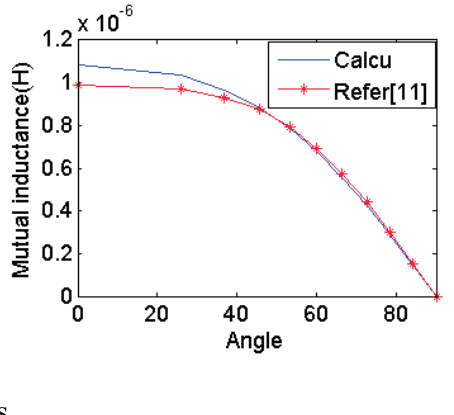
Figure 7. Mutual inductance simulation